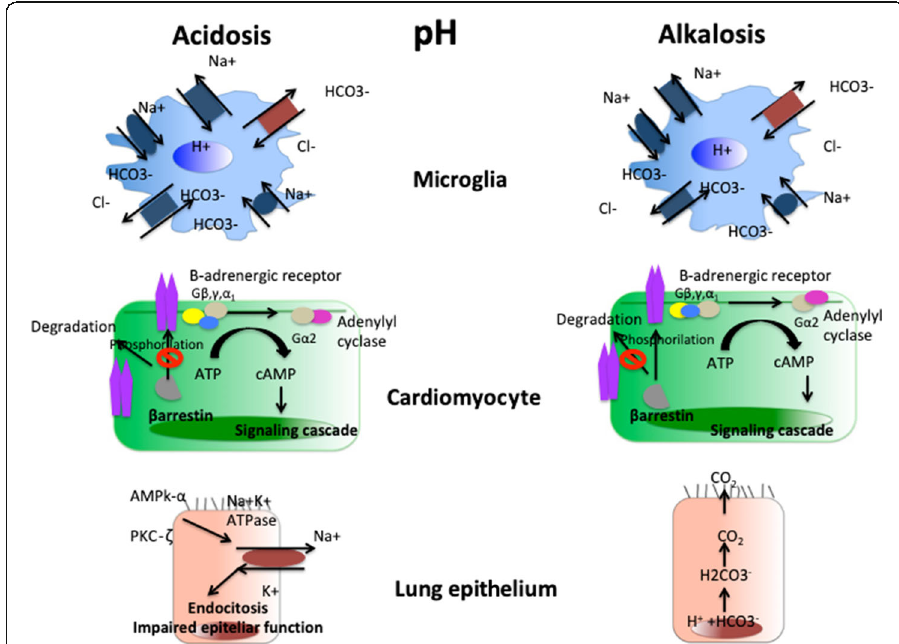
Fig. 1 Biological effects of pH on microglia, cardiomyocytes, and lung epithelial cells. Microglia expresses two classes of acid-base transporting proteins: acid loaders (red) and acid extruders (blue). In acidosis, acid extruder proteins are increased while in alkalosis these are downregulated. In cardiomyocytes, the regulation of the adrenergic receptors is determined by β -arrestins, which can trigger the internalization process of dephosphorization or degradation and therefore define the up- and downregulation of the internalized molecule either to recycling or degradation, respectively. In acidosis, adrenergic receptors are downregulated and less responsive to catecholamines. In the lung epithelium, reduction of lung edema clearance is associated with the endocytosis of the Na+/K+-ATPase from the plasma membrane of alveolar epithelial cells, which leads to decreased Na+/K+-ATPase activity. During acidosis, protein kinase C (PKC)- ζ phosphorylates the Na+/K+-ATPase α 1-subunit, leading to endocytosis of the Na+/K+-ATPase. The activation of PKC- ζ is regulated by AMP kinase (AMPK). Acidosis culminates in the Na+/K+-ATPase endocytosis from the cell plasma membrane. In the lung epithelium, alkalosis with low carbon dioxide and hyperventilation can determine increase of mechanical power and activation of the inflammatory